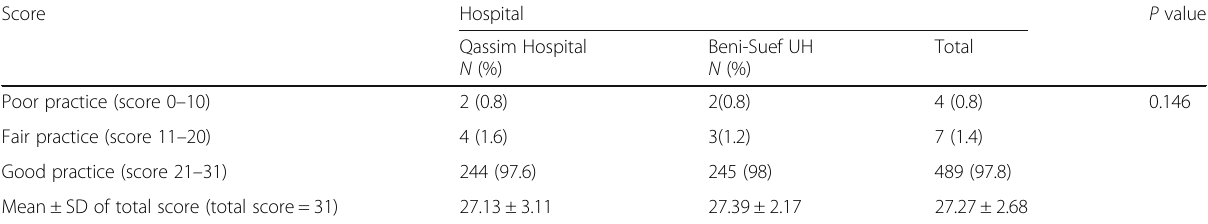
Table 5 Comparison of safe injection practice score among the study groups